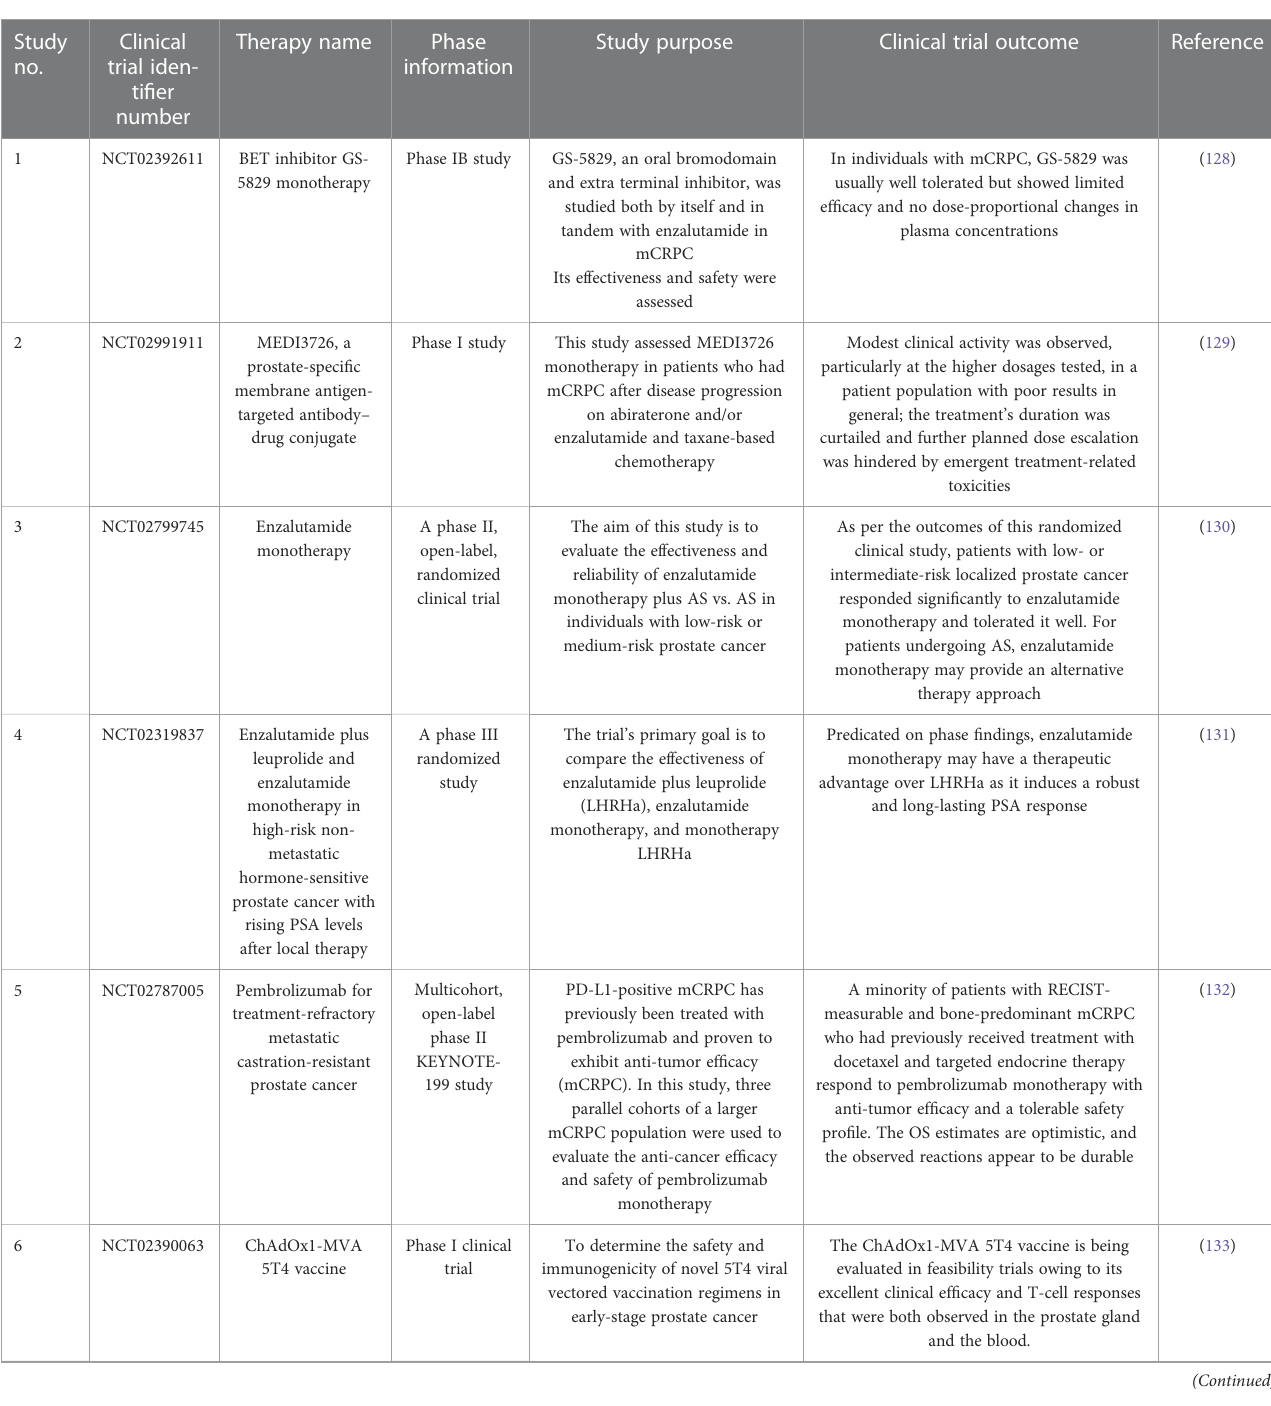
TABLE 1 Current clinical trials on